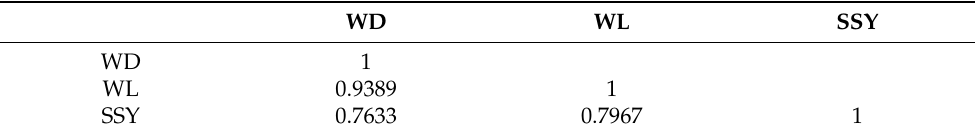
Table 3. Spearman’s rank correlation coefficient of data at Polavaram, Godavari River Basin.